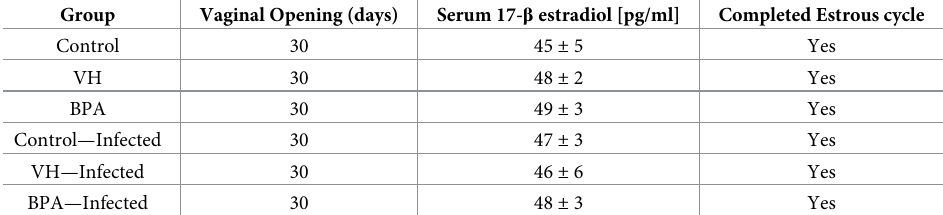
Vaginal Opening (days) Serum 17- β estradiol [pg/ml] Completed Estrous